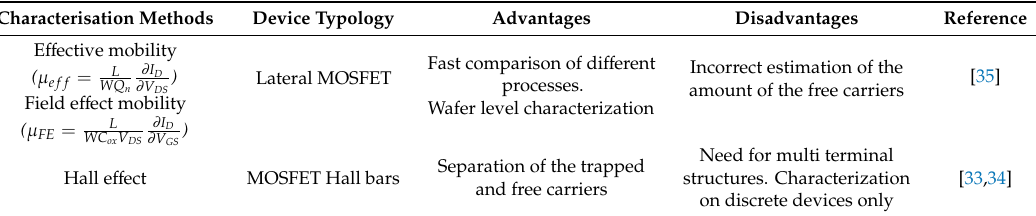
Table 3. Summary of the most widely used characterization techniques to evaluate the mobility in 4H-SiC